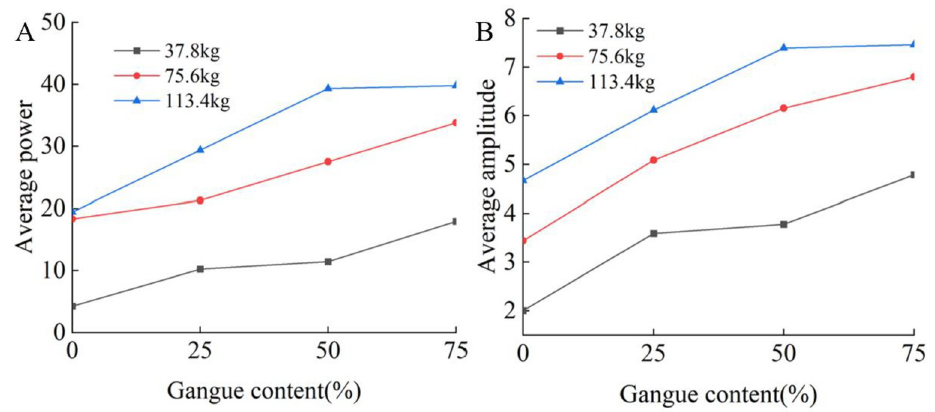
Fig 23. Relationship between gangue content and frequency domain characteristics. (A) Gangue content versus average power and under the total mass of 113.4kg, 75.6kg, and 37.8kg. (B) Gangue content versus average amplitude under the total mass of 113.4kg, 75.6kg, and 37.8kg.